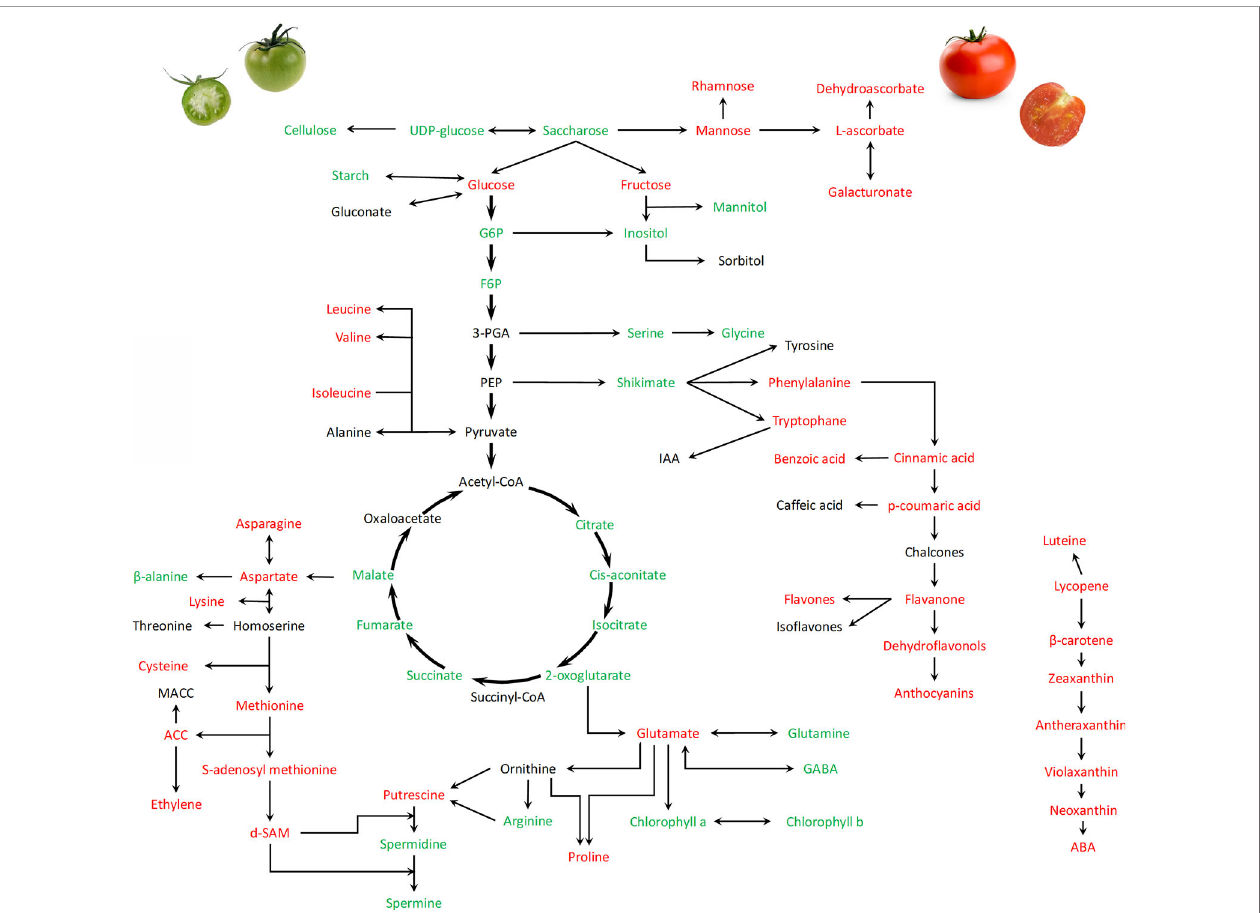
FIGURE 2 | Global overview of metabolic changes occurring during the transition from green expanding fruit to ripening processes (from 30 DAA to 60 DAA) in tomato fruit. Names of metabolites in red, green and black indicate increase, decrease or no changes, respectively. Metabolites are analyzed mainly in pericarps. The Figure summarizes data collected by Carrari and Fernie (2006); Gilbert (2009); Mounet et al. (2009); Centeno et al. (2011); Beauvoit et al. (2014); Biais et al. (2014), Van Meulebroek et al. (2015), Van de Poel et al. (2012), and Zhao et al.